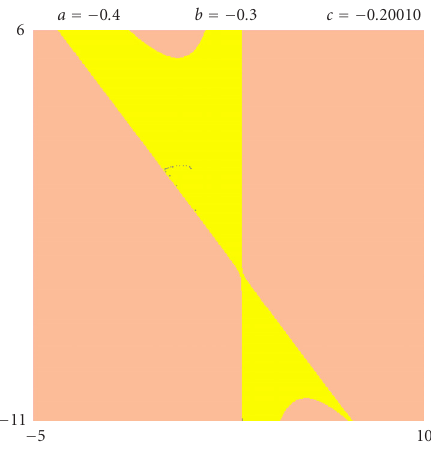
Figure 4.8. Basin connected and iterates of focal point inside the